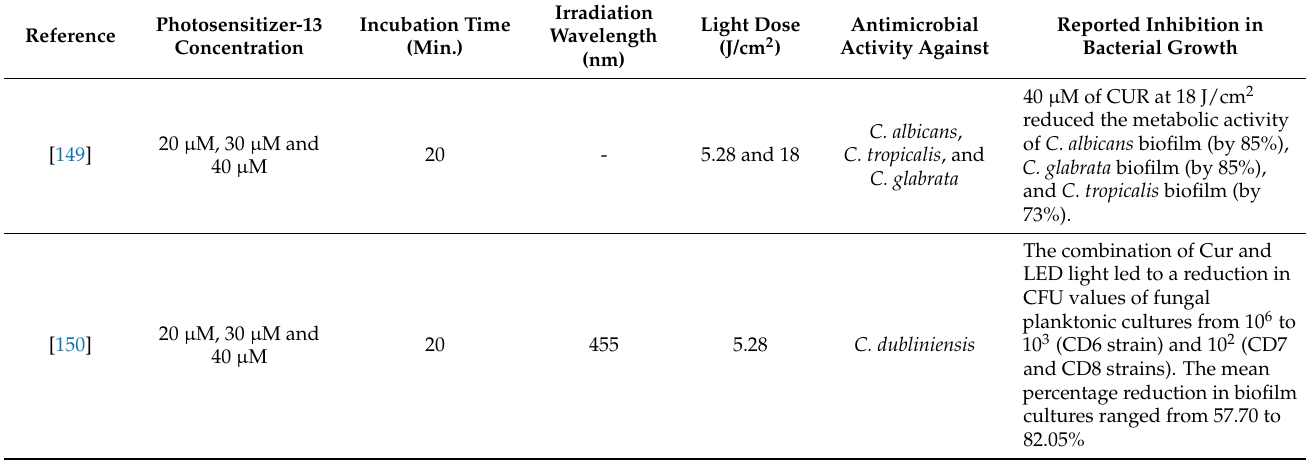
Table 3. Curcumin—photodynamic antimicrobial activity and dosimetry. Photosensitizer-13 Reference